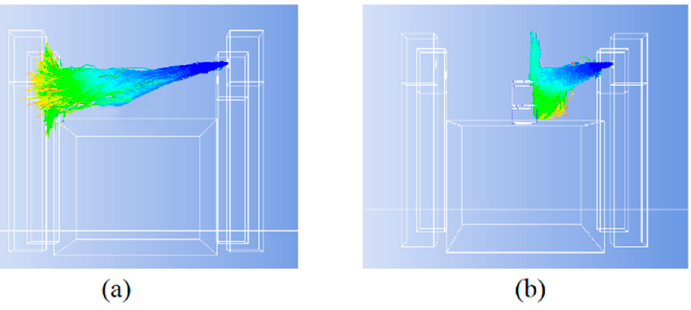
Figure 4. Dispersion of virus particles predicted by CFD: ( a ) without air purifier; ( b ) with air purifiers.